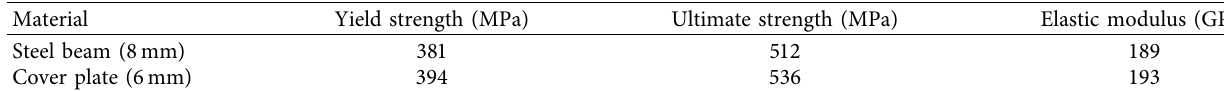
Table 2: Material properties of steel beam and cover plate.